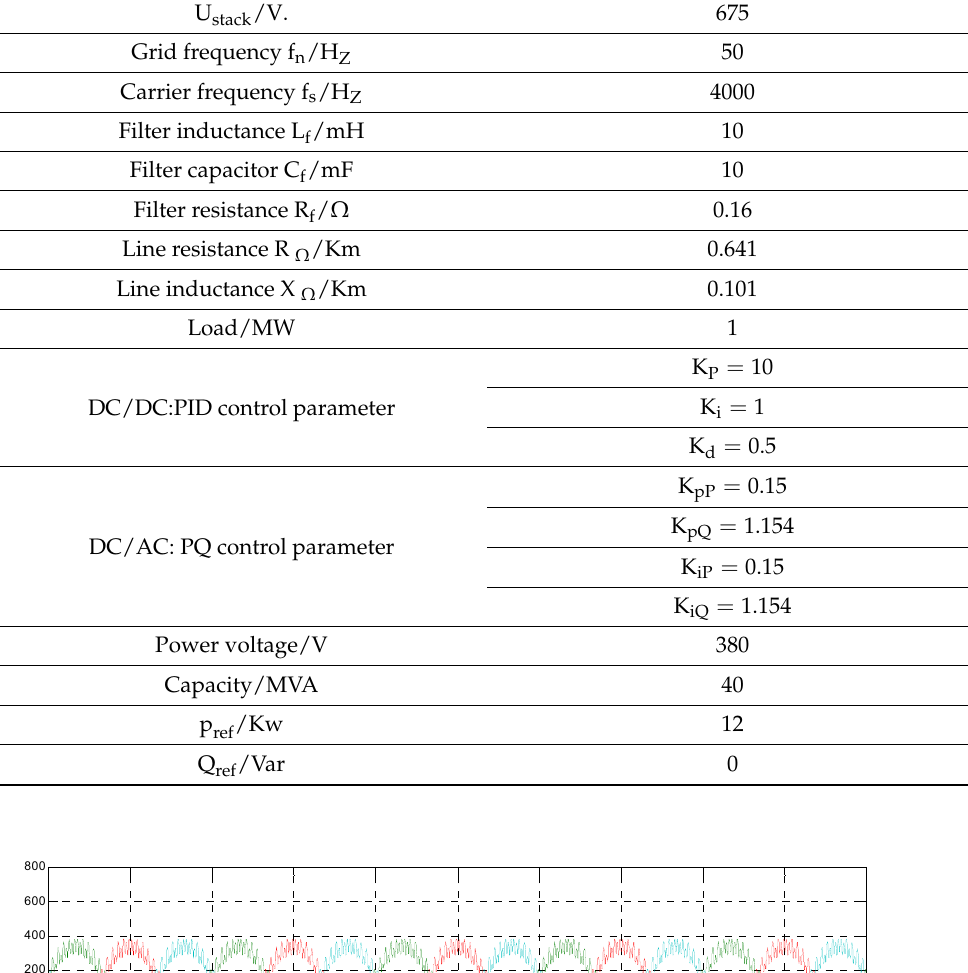
Table 1. Parameters used in simulation.